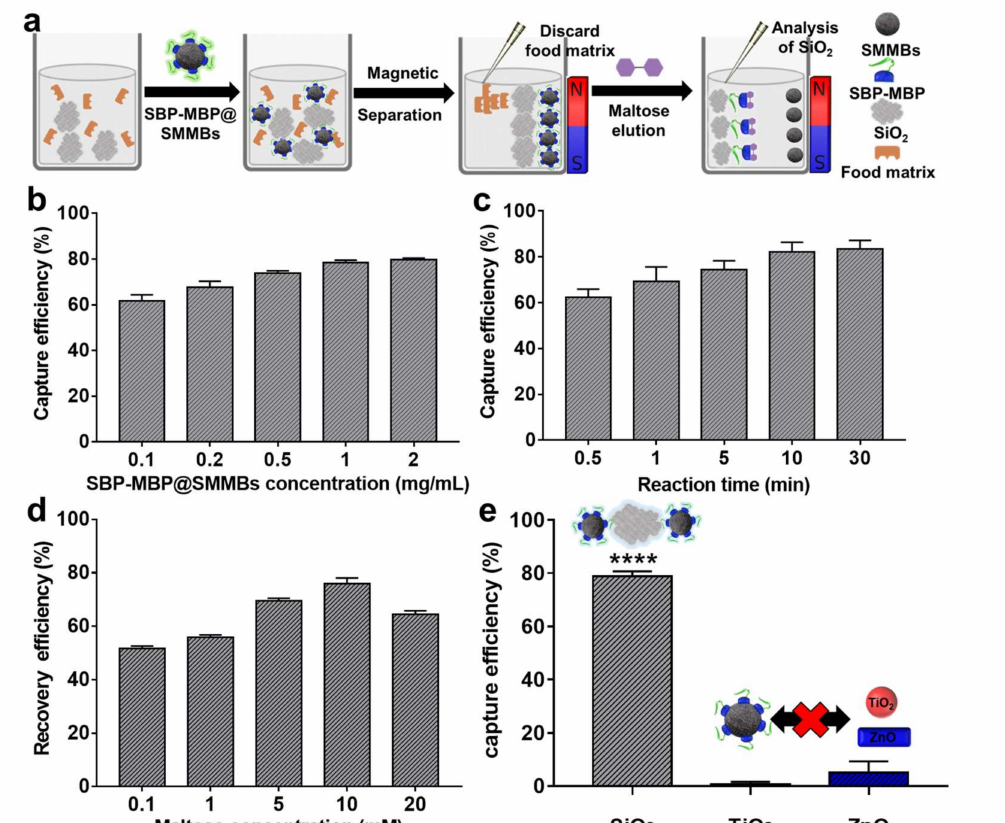
Figure 3. Optimization of experimental condition for the capture and recovery of SiO2 using SBP- MBP@SMMBs. ( a ) Schematic illustration showing the magnetic separation and recovery of SiO 2 using SBP-MBP@SMMBs. ( b , c ) The capture efficiency of SBP-MBP@SMMBs for SiO 2 as a function of the concentration of SBP-MBP@SMMBs and binding time in aqueous solution. ( d ) The effect of maltose concentration on recovery efficiency of captured SiO 2 from the surface of SBP-MBP@SMMBs. ( e ) The specificity of SBP-MBP@SMMBs for SiO 2 over non-target inorganic food additive TiO 2 and ZnO. The capture test was carried out with 1 mg/mL of SBP-MBP@SMMBs for 10 min. The asterisks (****) indicate significant difference at p < 0.0001 for SiO 2 over the non-target controls such as TiO 2 and ZnO. The error bars represent the standard deviation of capture and elution efficiency (n =